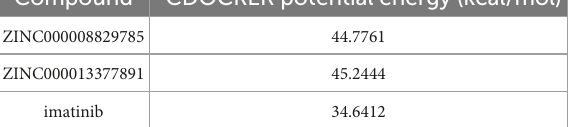
TABLE 4 CDOCKER Potential energy of compounds with platelet-derived growth factor receptor α (PDGFRA). Compound -CDOCKER potential energy (kcal/mol)